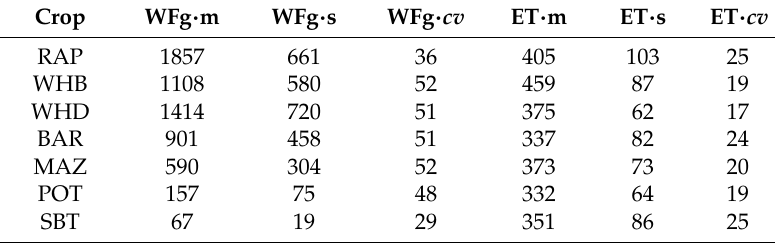
Table 3. Green water footprint (WF) (WFg in m 3 · Mg − 1 ) and evapotranspiration (ET in mm) for the major arable crops in Europe for the period 1992–2012. For crop abbreviations see Figure